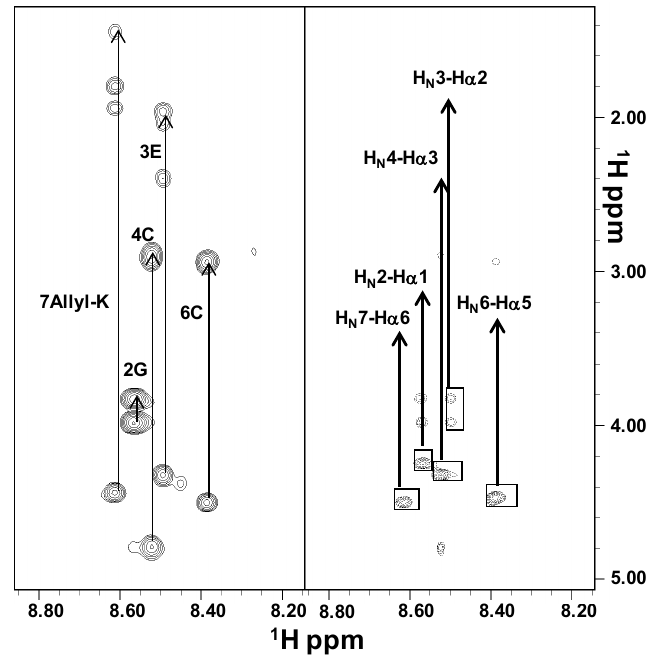
Figure 2. Comparison of 2D [ 1 H, 1 H] TOCSY ( left ) and ROESY ( right ) spectra of PepE in H 2 O/D 2 O (90/10). The H N -aliphatic protons correlation regions are shown in each panel; spin system assignments are indicated in the left side. In the right panel, sequential ROE contacts are highlighted by rectangles and the corresponding assignments are indicated.